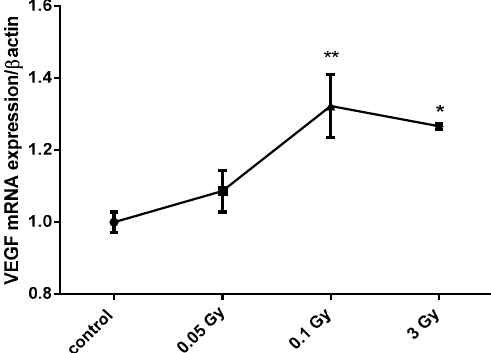
all the time points studied (Figure 2F). No additive e ff ect on VEGF expression was observed while using lower doses in both cell lines (Figure 2A,B,D,E), even though exposure to 0.1 Gy of X-rays in both iodine-su ffi cient and iodine-deficient conditions led to a VEGF increase. VEGF up-regulation was transient as none of the above-mentioned e ff ect was observed after 24 h.